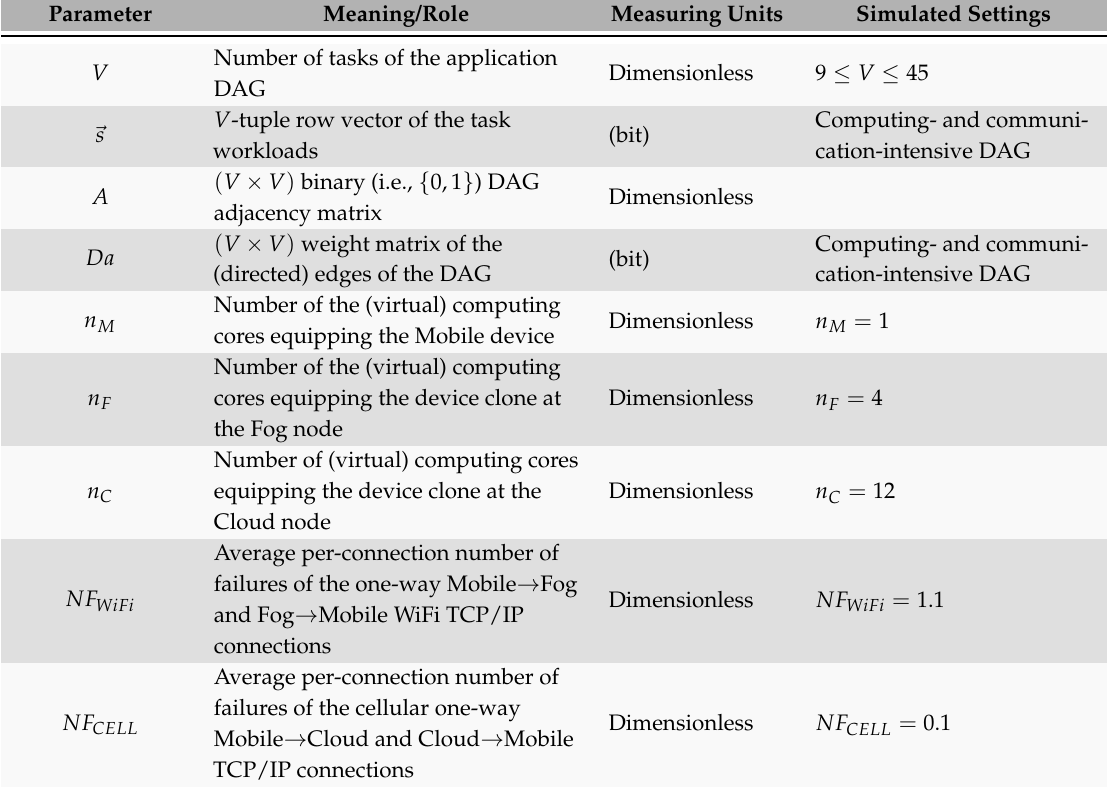
Table A2. Input parameters of the VirtFogSim simulator and their simulated settings of Section 6.